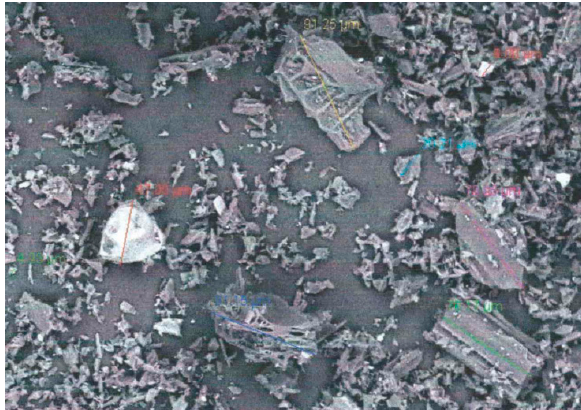
Figure 5. SEM image of the charcoal particles with ash particles present.